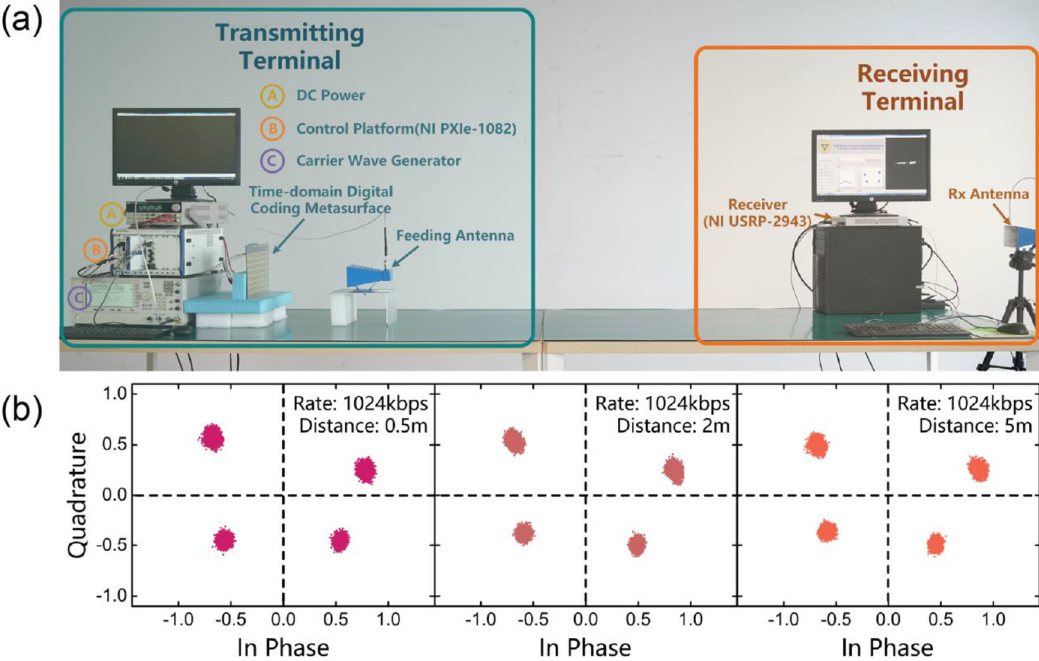
Fig. 8. QPSK transmission system based on space-time coding digital metasurfaces (adapted from [35]). (a) Photograph of prototype and measurement setup in an indoor scenario. (b) Received constellation diagrams for different transmission